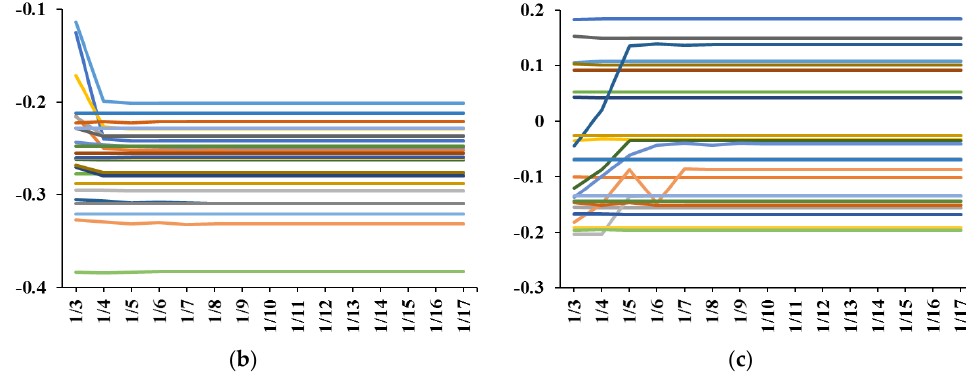
Figure 10. Timing of break points detected in the time series ( a ), averages of trend components before break points ( b ) and averages of trend components after break points ( c ), influenced by different settings of h parameter sampled in reservoir area. Values in the x -axis indicate different settings of h parameter, values in the y -axis (a) indicate dates of break points detected by BFAST algorithm while values in y -axis (b and c) indicate averages of trend components decomposed by BFAST algorithm. Each line drawn in each diagram indicates their corresponding values of y -axis influenced by different settings of h parameter. They were drawn in different colors to distinguish different sample pixels. The numbers behind each line in legend indicate the IDs of sample pixels. All of the three diagrams share the same legend to diagram (a).